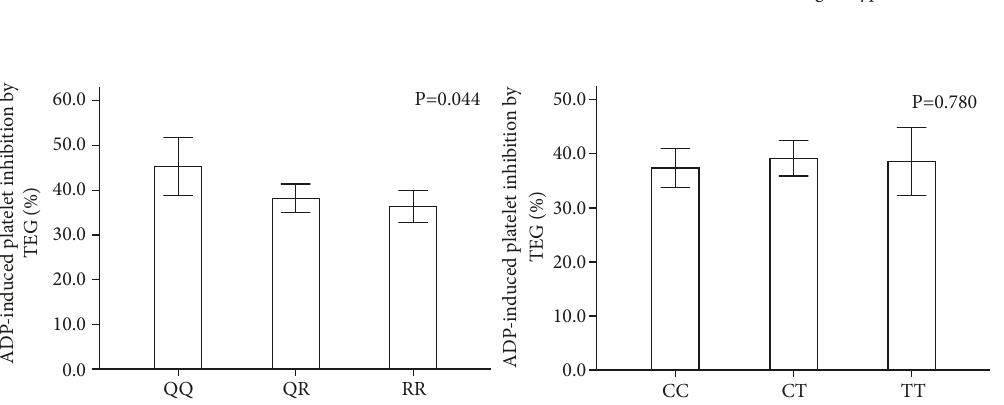
Figure 1: Association of clopidogrel genotypes and ADP-induced platelet inhibition by TEG. The top of each bar indicates the average of ADP-induced platelet inhibition. The whiskers above and below the bar indicate 95%